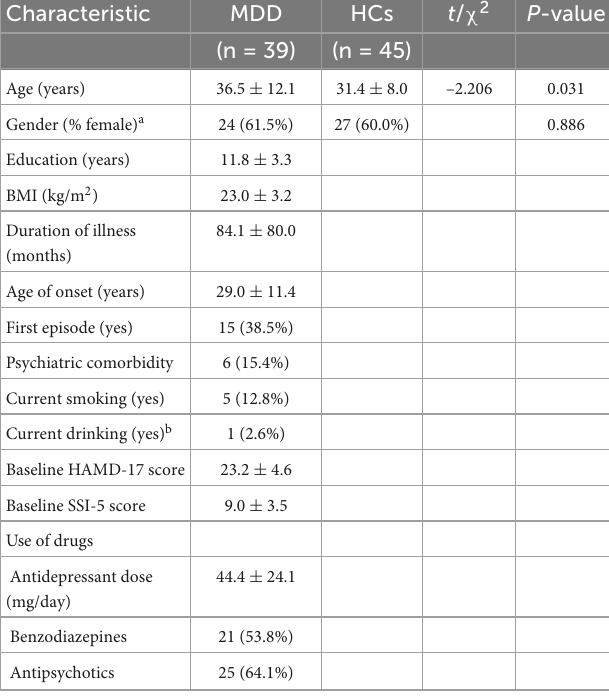
TABLE 1 Baseline characteristics of